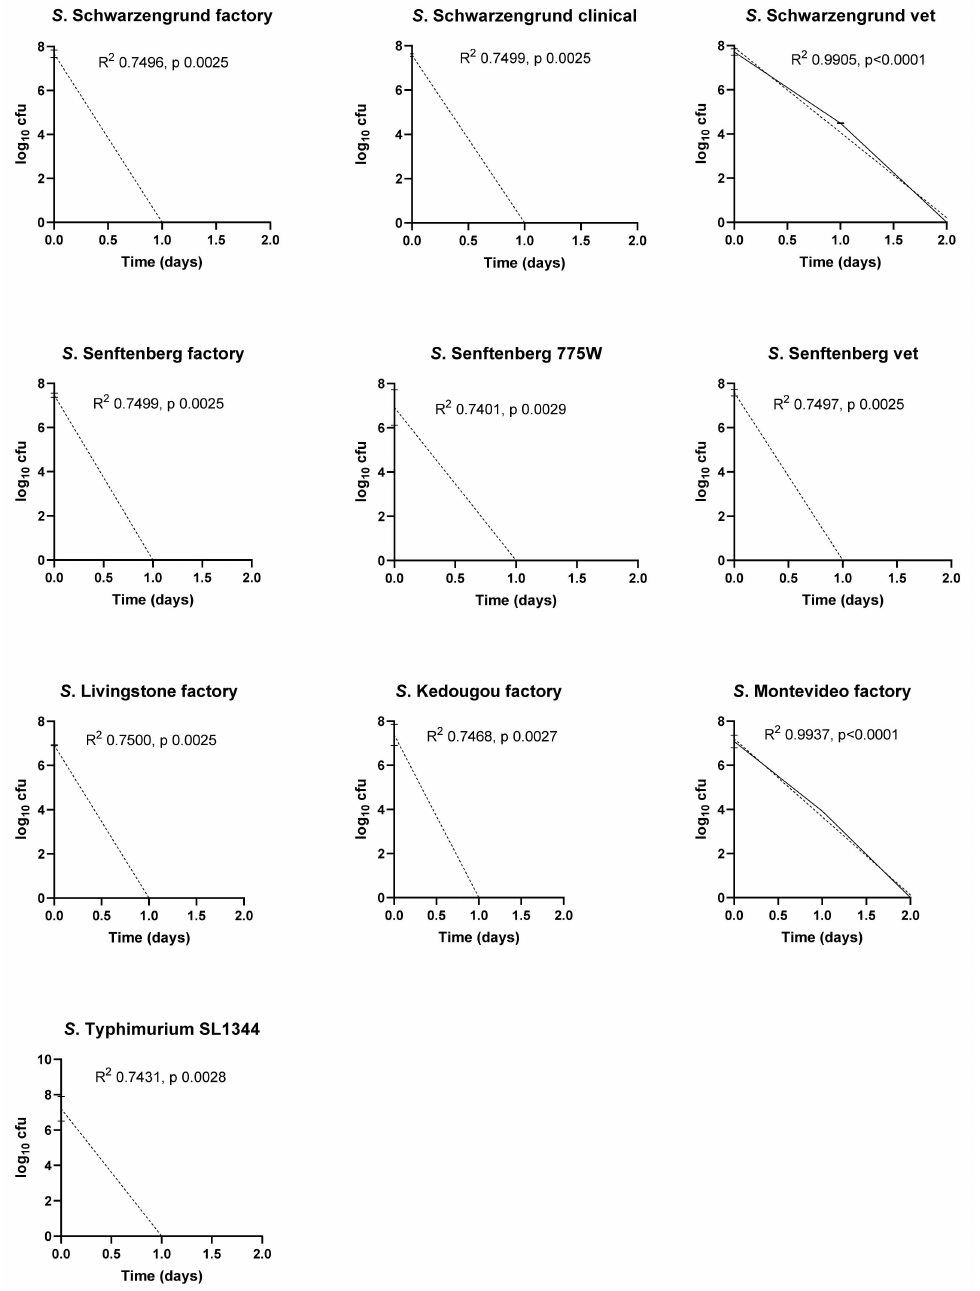
Figure 3. Survival of Salmonella isolates on stainless steel at 37 ◦ C, 20% RH. Viable counts are shown as log 10 cfu/coupon at each time point. Results are plotted as means of triplicate experiments with bars showing standard deviation. Best-fit lines determined by log-linear regression are included for each isolate with R 2 and p